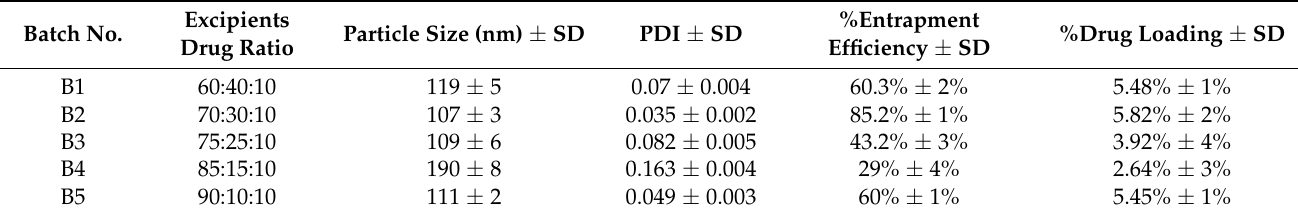
Table 4. Drug entrapment efficiency and drug loading of optimized batch.